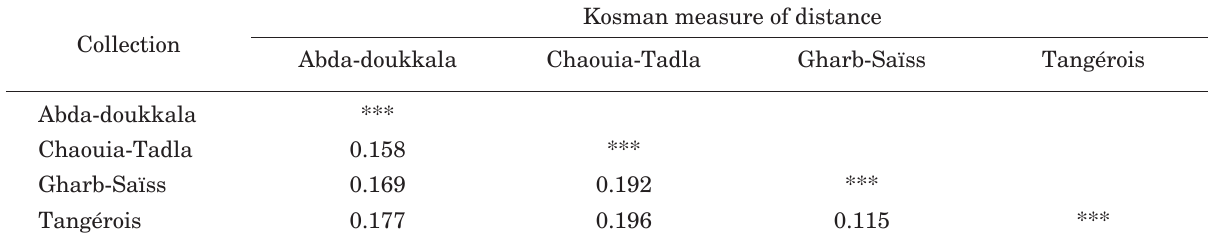
Table 4. Kosman measures of distance between virulence phenotypes of four collections of Puccinia recondita in Morocco during 2005 and